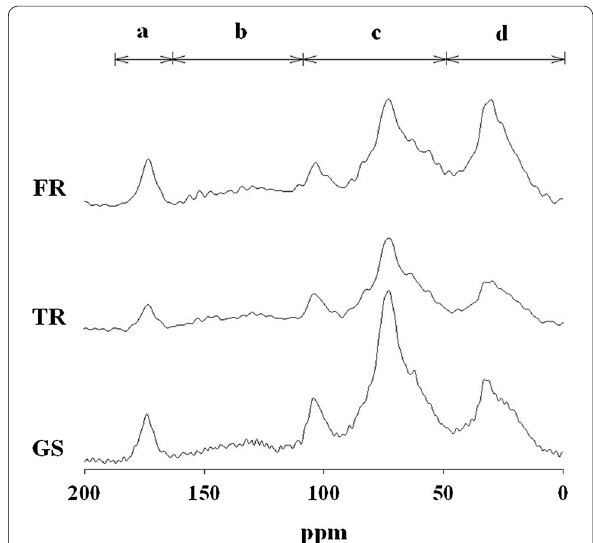
Fig. 1 CP/MAS 13 C NMR spectra of whole soils in the O/A horizon in forest (FR), transition (TR), and grassland (GS) sites. a carboxyl‑C, b aromatic‑C, c O‑alkyl‑C, d alkyl‑C